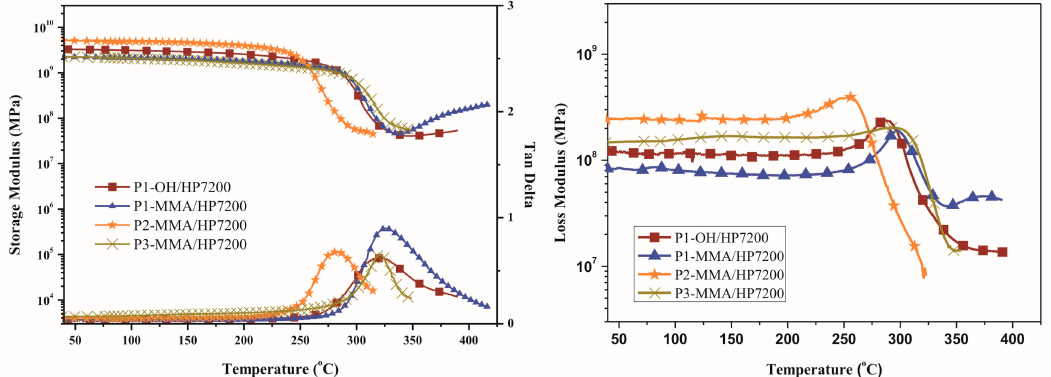
Figure 8. DMA thermograms of the prepared